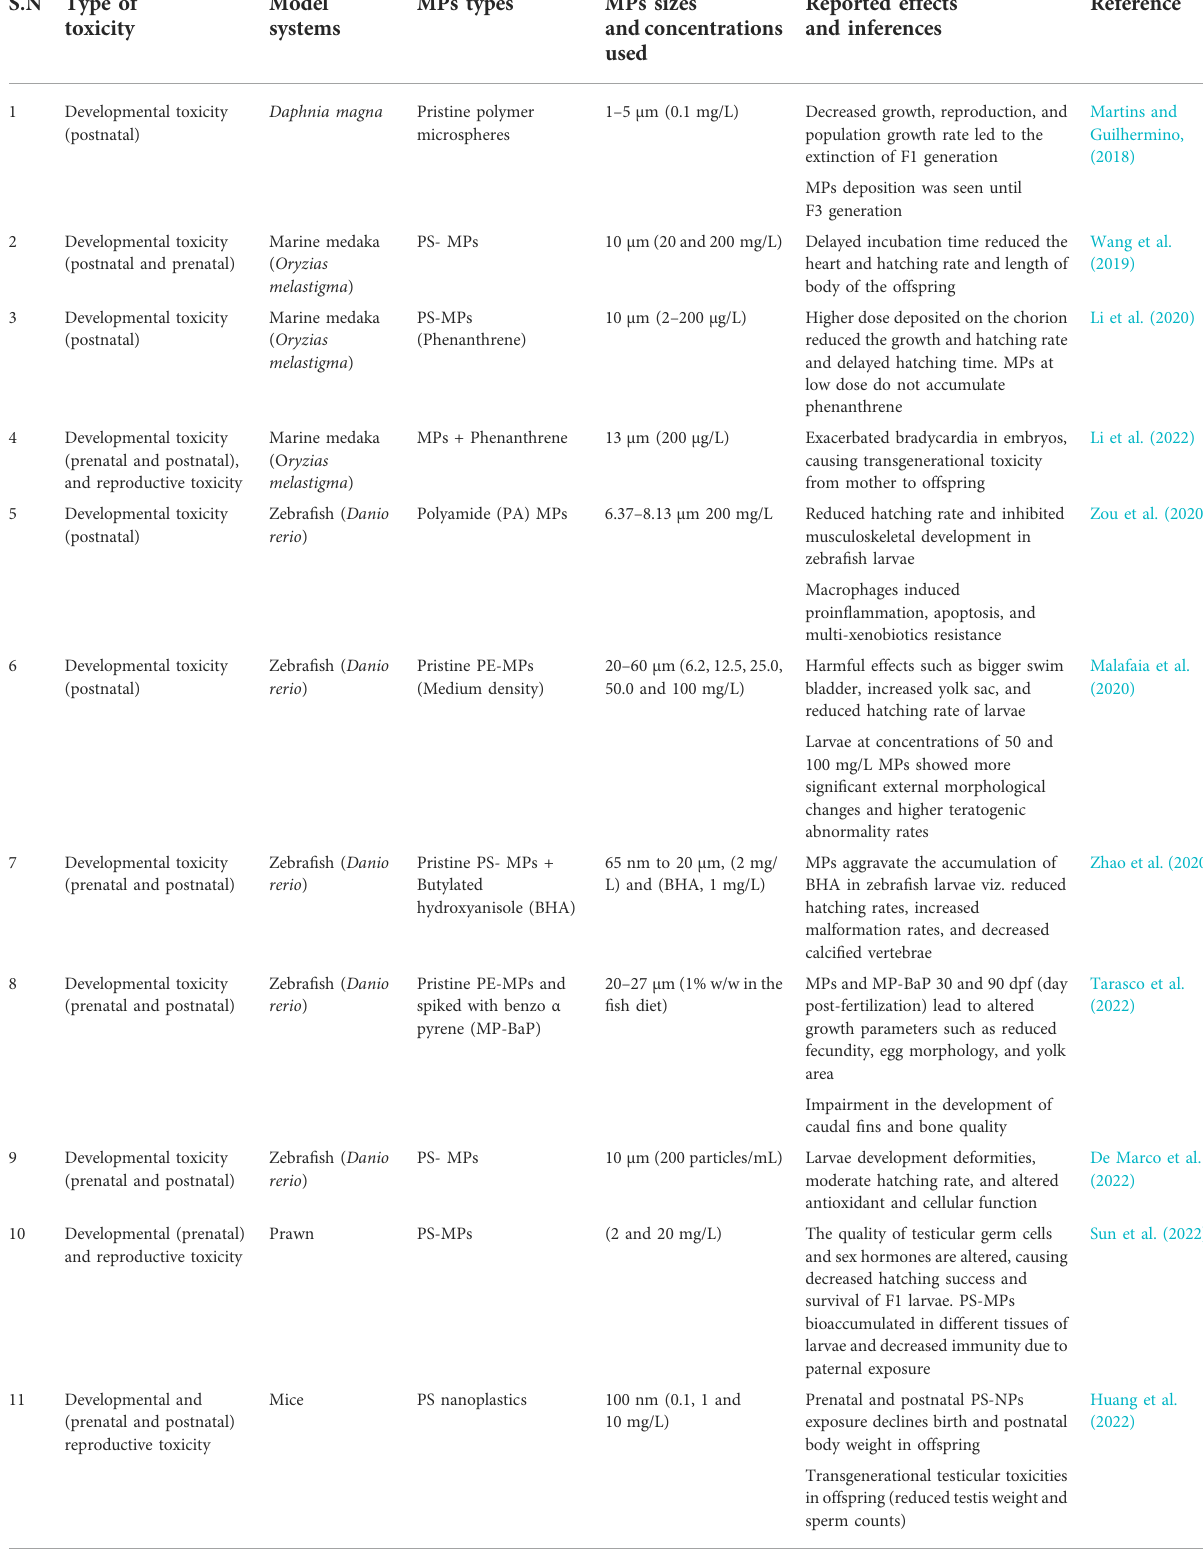
TABLE 1 Summary of experimental studies showing developmental and harmful effects of MPs in different species and their